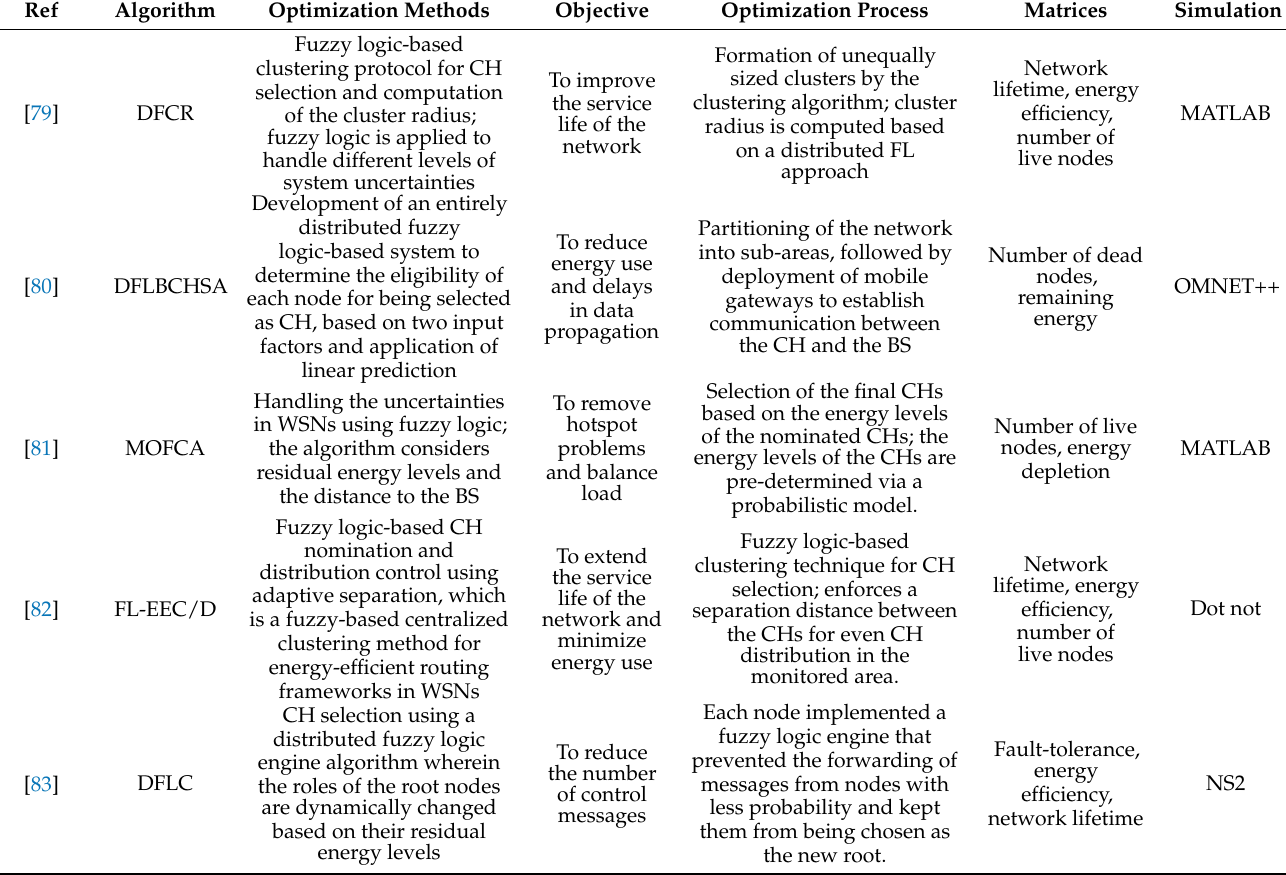
Table 5. Comparison of studies involving fuzzy